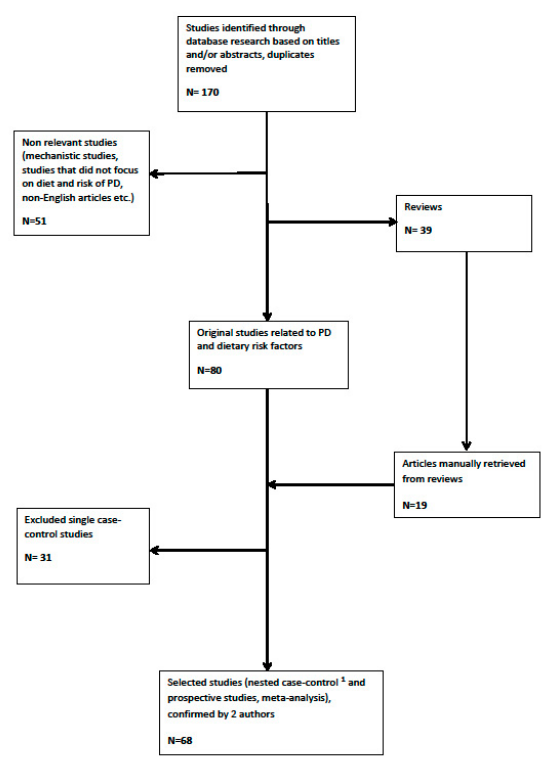
Figure 2. Flowchart of study selection ( 1 except for Figure 2 . Flowchart of study selection ( 1 except for microbiota).